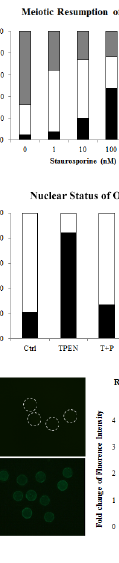
Figure 5. TPEN controls meiotic resumption in a PKC-depen- dent manner. (A) Nuclear distribution was examined after 25 h of IVM and treatment with various concentrations of staurosporine. The percentages of oocytes at the GV, GVBD, and MI stages are shown. ( B ) Nuclear distribution was examined after 25 h of IVM and treatment with TPEN and/or PMA. The percentages of oocytes at the GV, GVBD, and MI stages are shown. ( C ) Change in the level of free zinc following PMA treatment. Zinc content was analyzed using Photoshop and was normalized against the level in the control group (set at 1). Ctrl, control group; TPEN, oocytes matured in the presence of 2.7 m M TPEN; T + P, oocytes matured in the presence of TPEN and PMA; PMA, oocytes matured in the presence of PMA only. PMA (in figure C), GV-stage oocytes treated with PMA for 1 h. White dashed lines indicate the peripheries of oocytes. Data are expressed as mean values 6 SEM of three independent experiments. *, P , 0.05.